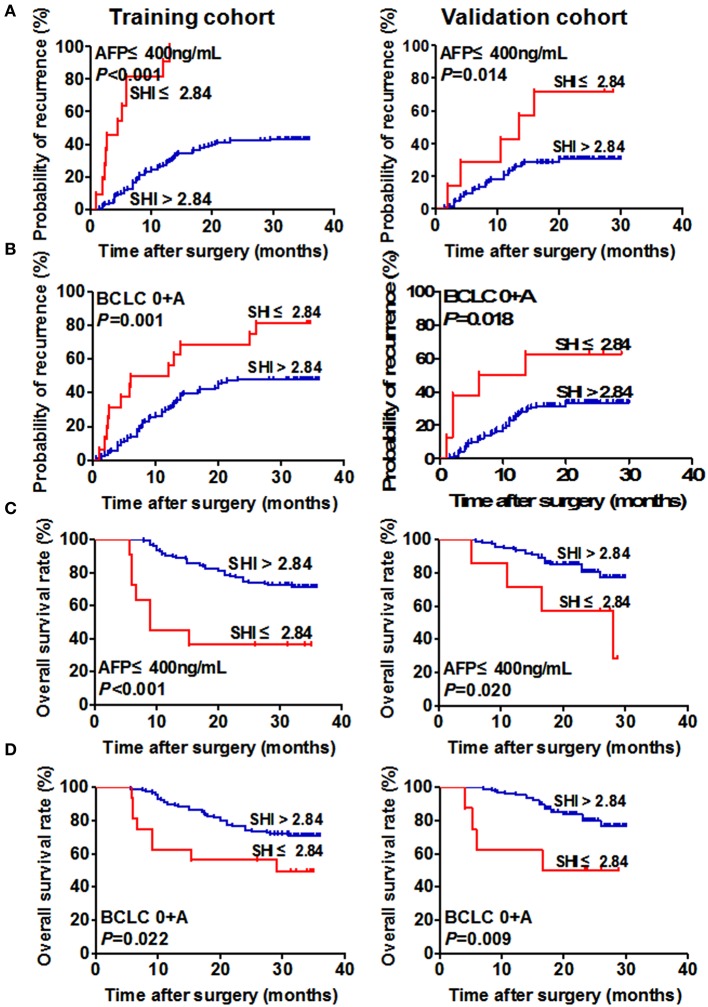
Prognostic significance of SHI of HCC patients in the low-risk and AFP ≤ 400 ng/mL subgroups. Kaplan–Meier analysis of TTR of HCC patients with AFP ≤ 400 ng/mL and BCLC 0+A in the training (A, left and B, left) and validation (A, right and B, right) cohorts. Kaplan–Meier analysis of OS of HCC patients with AFP ≤ 400 ng/mL and BCLC 0+A in the training (C, left and D, left) and validation (C, right and D, right) cohorts.